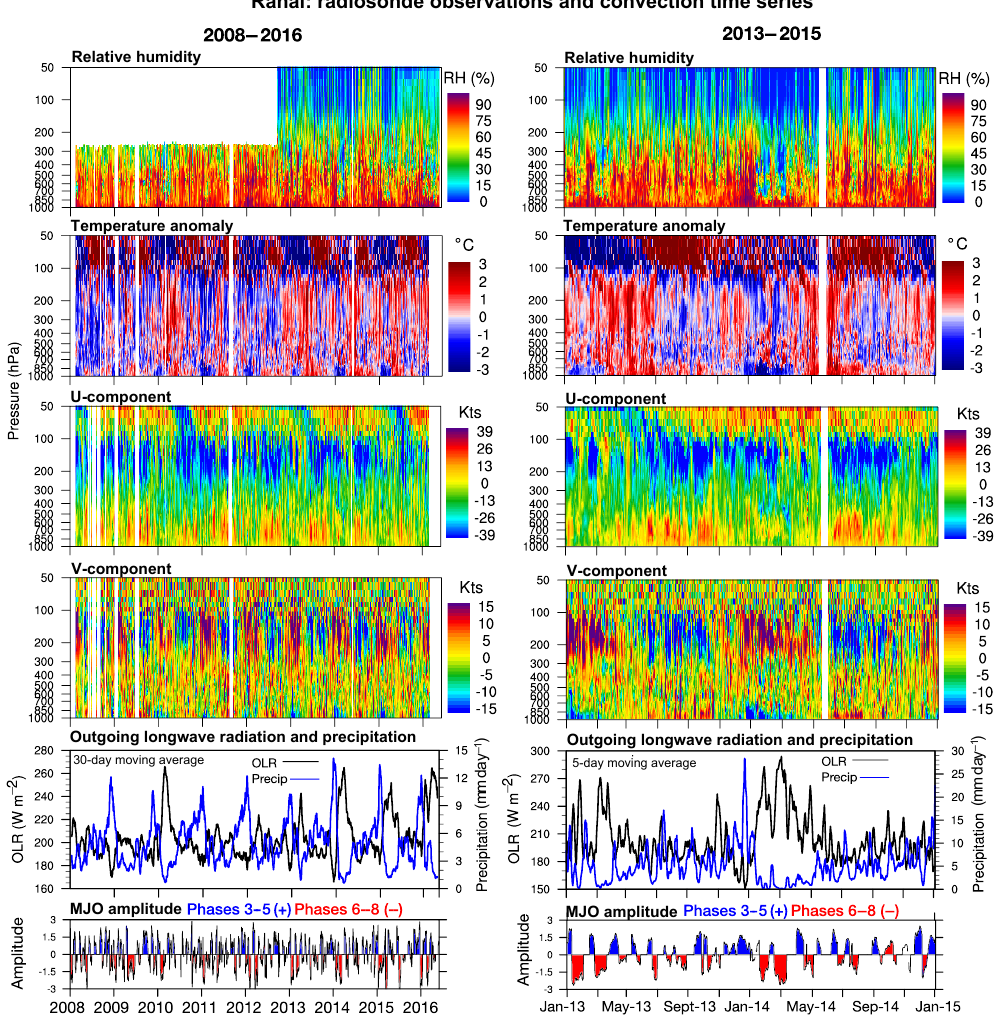
Figure 9. Time series of temperature, relative humidity, u and v winds, outgoing longwave radiation, precipitation, and the MJO active and suppressed phases at Ranai. The left column is the entire study period 2008–2016, and the right column is a subset of that time period from 2013 to 2015. T , RH, and wind data in the first four rows are from the radiosonde observation dataset in Sect. 2 and were interpolated if data were missing for no more than 5 consecutive days. The Ranai radiosonde equipment reported RH only below the 300hPa level until 2012 and is therefore missing. Areas of the time series shaded in white in the first four rows represent extended periods of missing observations or dates that did not pass quality control. OLR (black) and daily precipitation (blue) in the fifth and sixth rows come from the MERRA2 dataset. To reduce noise, OLR and precipitation have moving average filters applied. The MJO amplitude was split into active phases (blue), which enhance precipitation in Ranai (phases 3–5), and suppressed phases (red), which suppress precipitation in Ranai (phases